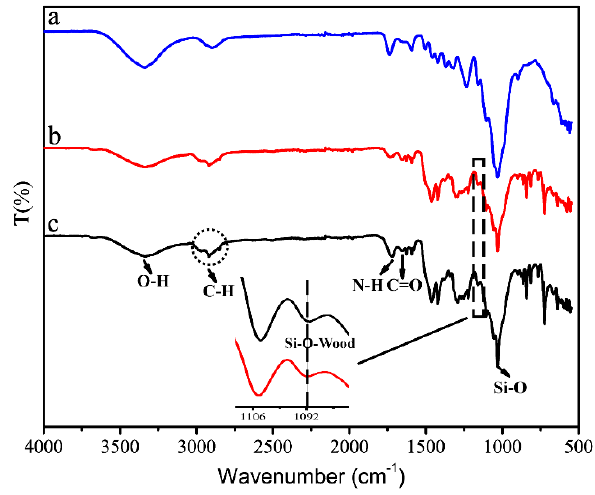
Figure 1. FT-IR spectra for ( a ) the untreated wood, ( b ) the sol coating composite, ( c ) the sol coating composite under UV-light radiation (340 nm) for 480 h.